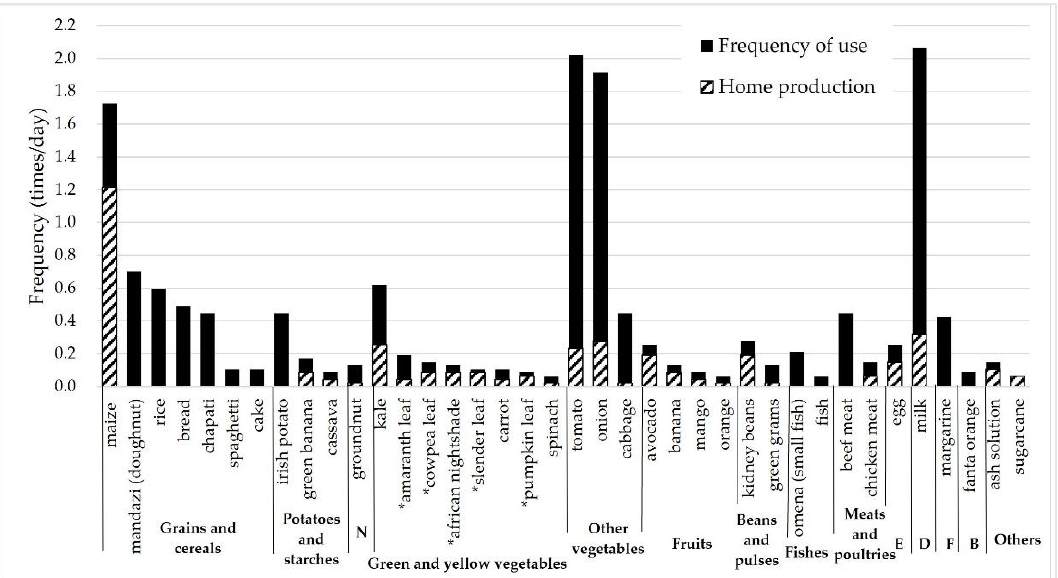
Figure 3. Frequency of consumption and home production of each food item in Vihiga. (Bold font indicates food groups. N: Nuts and seeds, E: Eggs, D: Dairy products, F: Fats, B: Beverages. * African leafy vegetables, A total of 64 items were consumed, 32 items were homegrown or produced in 12 households in Vihiga. Foods rarely consumed (less than 0.05 times per day), tea leaves, coffee, sugar, salt, royco (seasoning), and cooking oil were